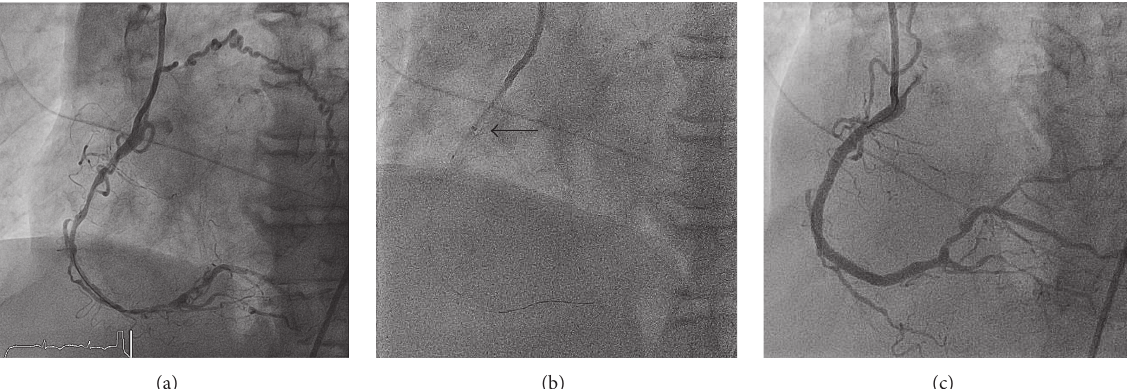
Figure 2: Successful PCI of the RCA using the GBAT technique. (a) Diffusely diseased RCA after predilatation. (b) Advancement of the GuideLiner using GBAT; black arrow indicated the tip of the GuideLiner. (c) Successful PCI of the